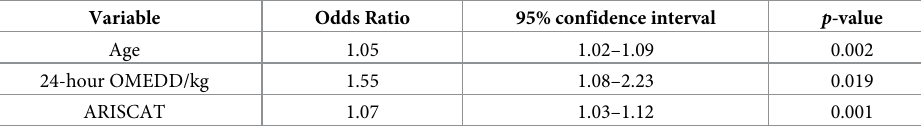
Table 4. Final multivariable logistic regression model for